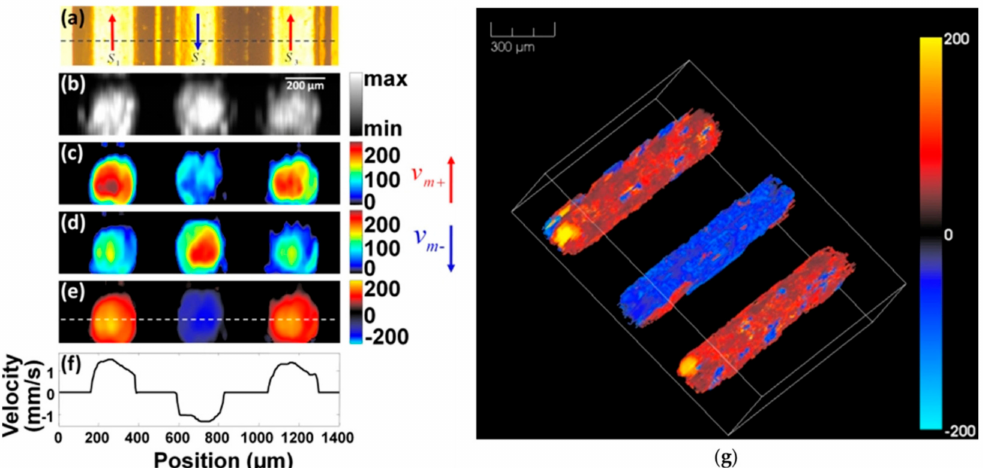
Figure 4. PA Doppler flowmetry. ( a ) PA Doppler bandwidth as a function of flow velocity; ( b – f ) PA flow imaging at different velocities and directions; ( g ) a 3D visualization of the PA flow imaging. Reprinted with permission from